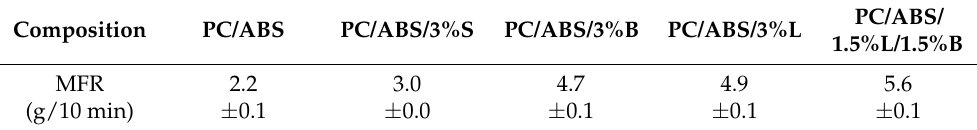
Table 3. Results of the mass flow rate of the obtained materials.